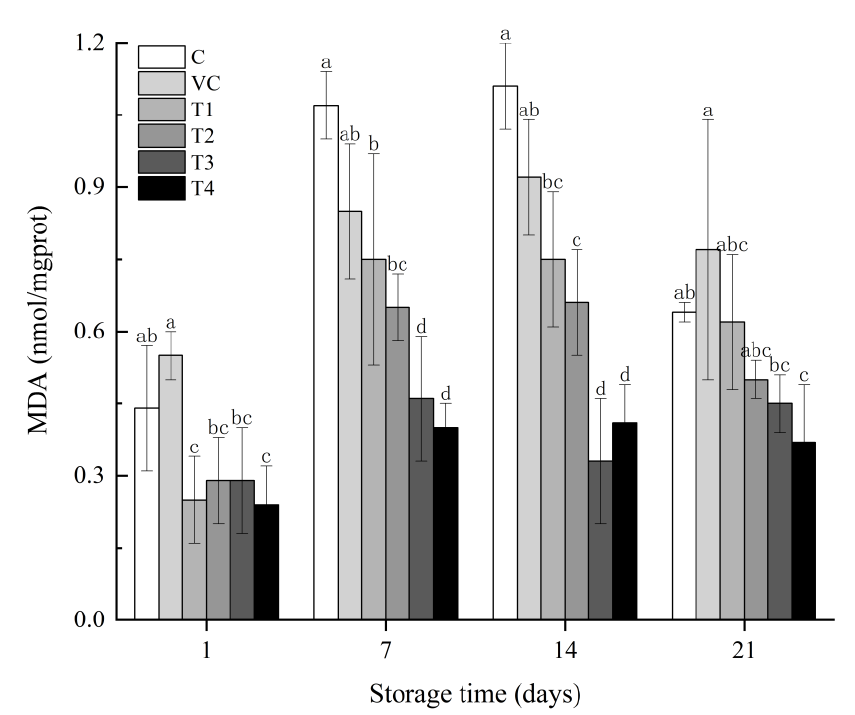
Figure 1. Effect of adding antioxidants on TBARS values of frankfurters during storage at 4 °C (n = 6). Note: Standard error bars are indicated. Different letters on the bars represent significant differences ( p < 0.05) in samples. Treatments: C: control, without antioxidant; VC: 0.025% sodium D-isoascorbate; T1 T2, T3, and T4: contained 0.06%, 0.12%, 0.18%, and 0.24% flavonoid extracts from C. paliurus , respectively.